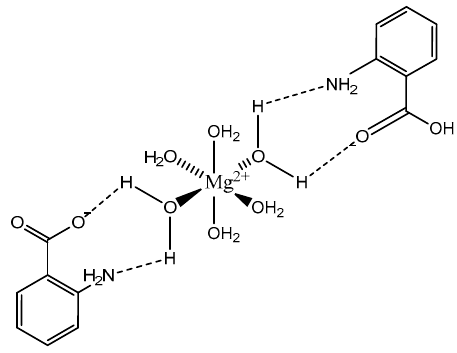
Figure 8. Structural illustration of the magnesium anthranilate structure proposed by Schmidbaur et al. [89]. The structure is devoid of two interstitial waters.